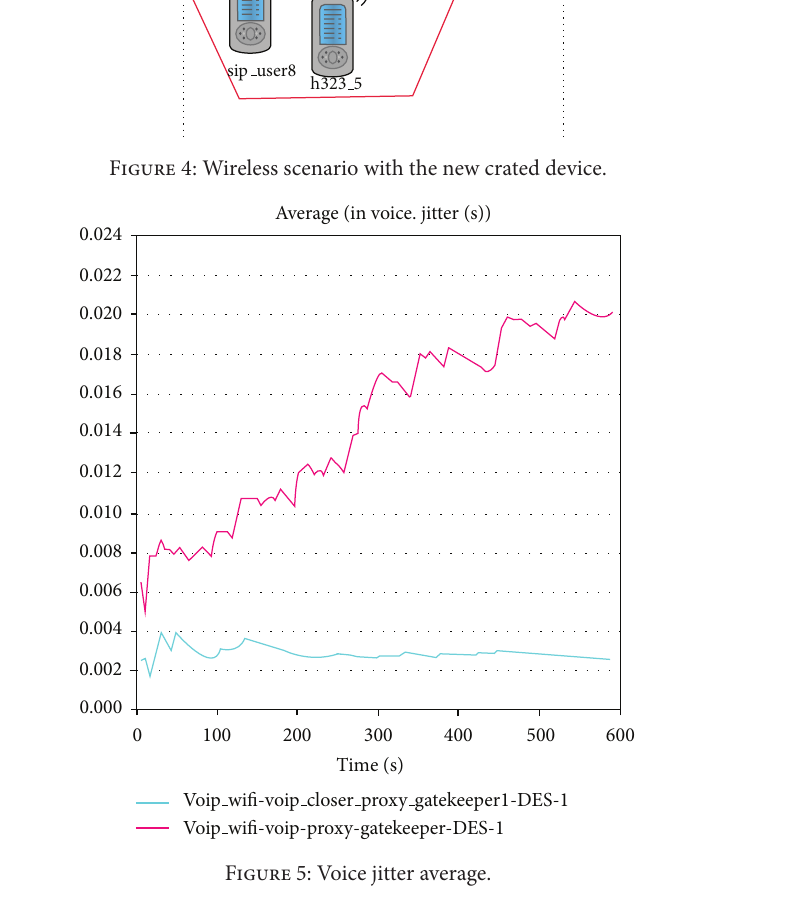
Figure 5: Voice jitter